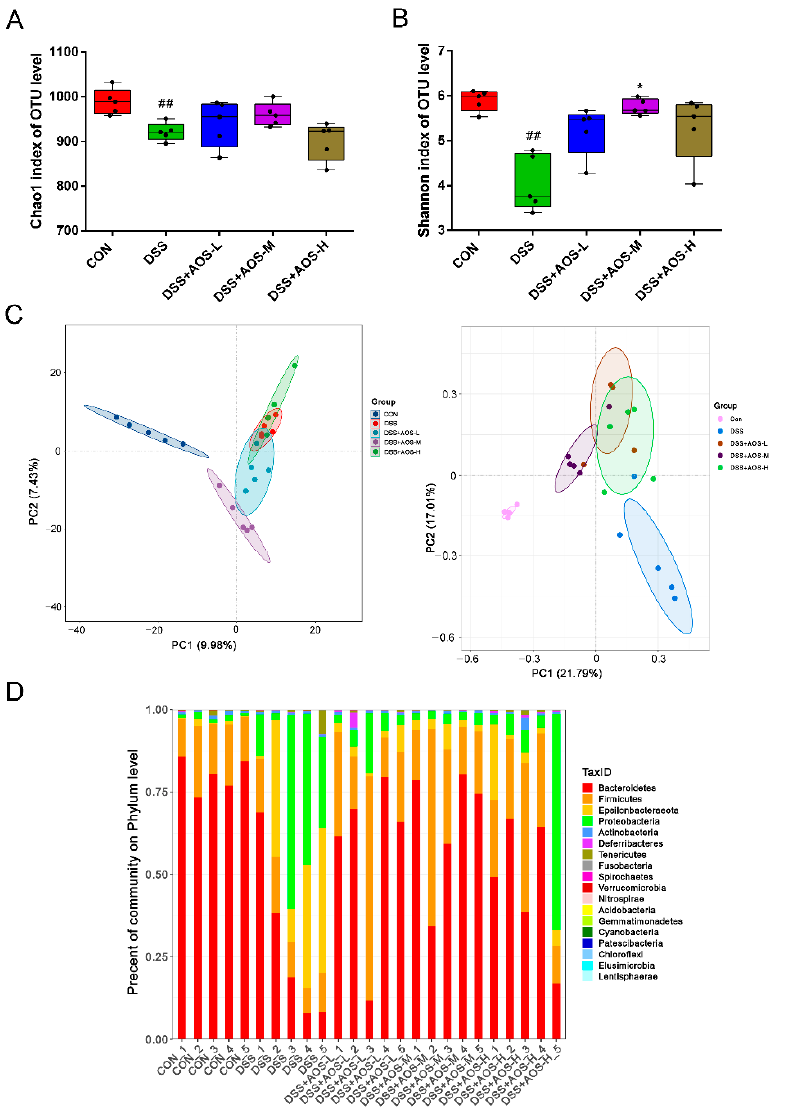
Figure 7. Effects of AOS on gut microbiota overall structure as detected by gut microbiota composition analysis through high-throughput sequencing of 16S rRNA genes. ( A ) Alpha diversity measured by Chao1. ( B ) Alpha diversity measured by Shannon index. ( C ) Beta diversity evaluated by PCA and PCoA analyses. ( D ) Bacterial taxonomic profiling at phylum level. * p < 0.05 vs. DSS group; ## p < 0.01 vs. Control group; n = 5.